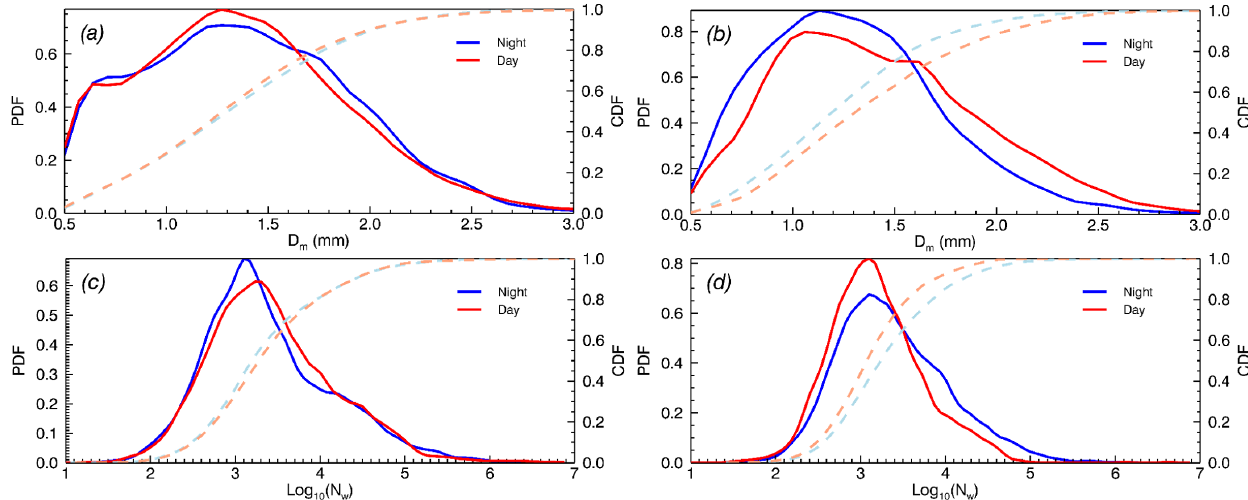
Figure 12. PDF and CDF of (a) D m ( (b) D m ) and (c) N w ( (d) N w ) for all rainfall types in the summer (winter) season. Red and blue solid lines represent the PDF of DT and NT, respectively. The light red and blue broken lines represent the CDF for each